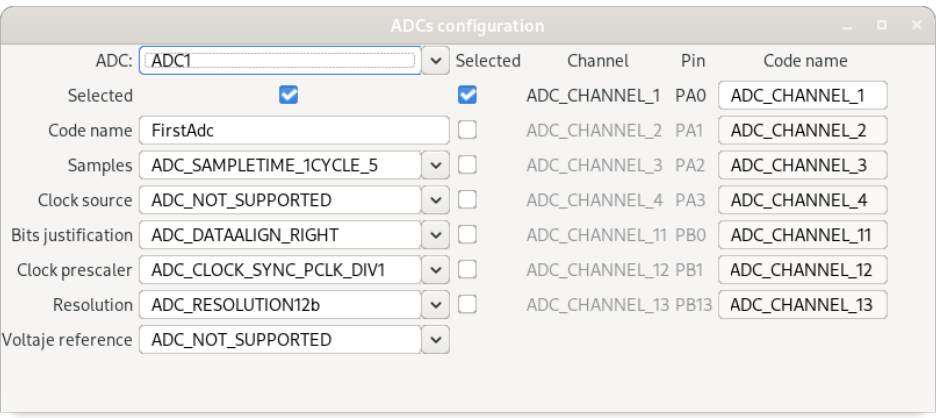
Figure 9. Analog-to-Digital Converter configuration